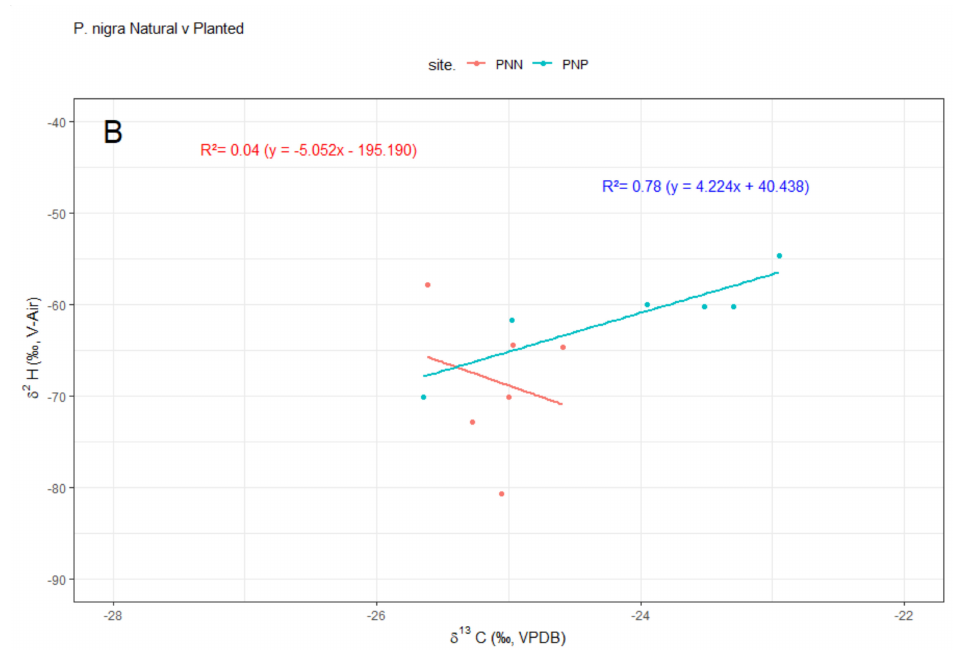
Figure 4. Relationships between stable isotopes ( δ 13 C and δ 2 H) in wood of ( A ) Pinus pinaster and ( B ) P. nigra for natural (PNN, PPN; red lines, symbols and equations) and planted (PNP, PPP; blue lines, symbols and equations) stands along an aridity gradient in south-eastern Spain. Note that δ 13 C and δ 2 H negatively covaried in planted forests. Abbreviations: PPN, P. pinaster natural; PPP, P. pinaster planted; PNN, P. nigra natural; PNP, P. nigra planted. Compositions fall on two distinct trends: the dry 2012 year and post-drought, wet years 2013, 2014 and 2015.